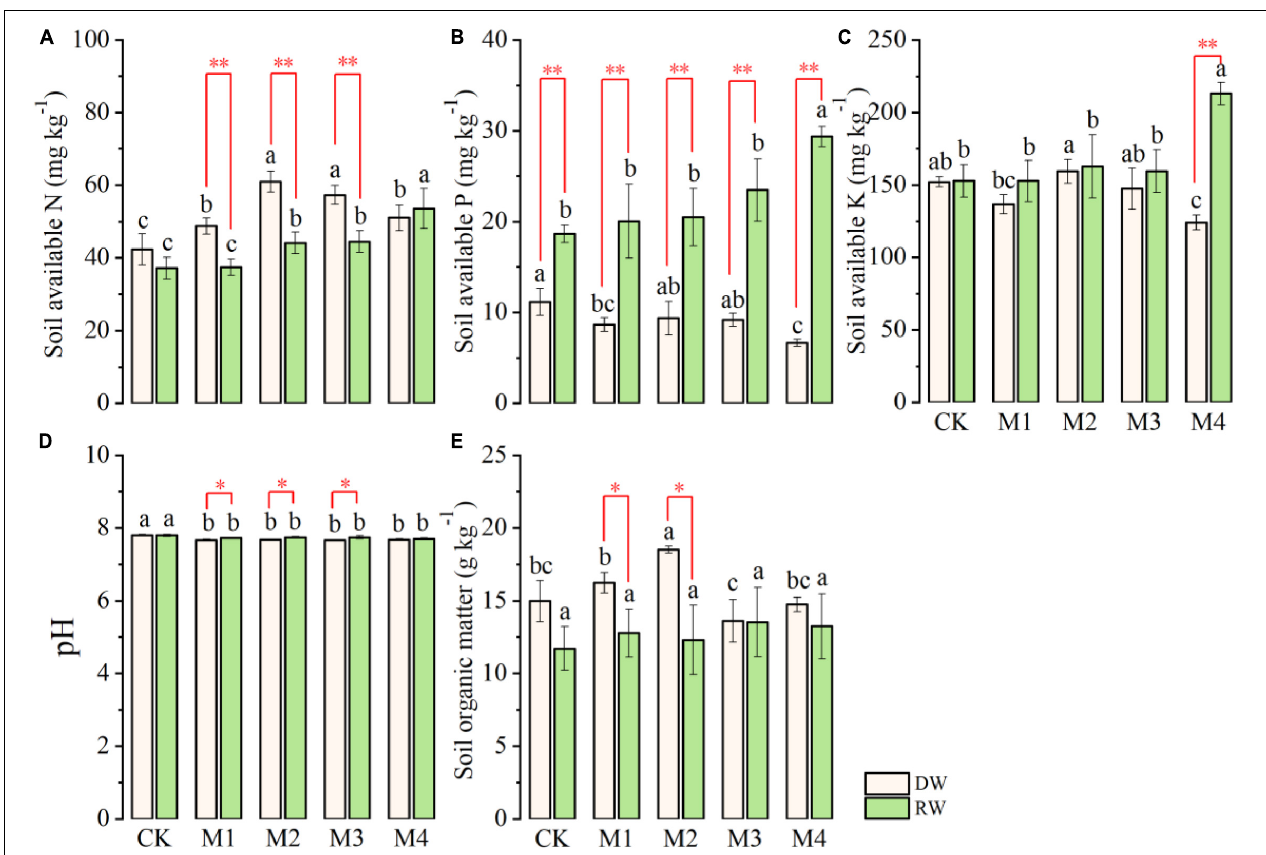
FIGURE 5 | Post-harvest soil chemical properties ( A , available N, AN; B , available P, AP; C , available K, AK; D , pH; E , organic matter, SOM) of dryland crop–wheat (DW) and rice–wheat (RW) under different N treatments. The different lowercase letters in the same crop rotation indicate significant differences ( p < 0.05) among the N treatment. The symbols ∗ , ∗∗ indicate significance at p < 0.05, 0.01 between DW vs. RW, respectively; blank is not significant.